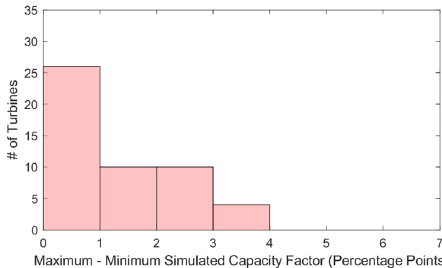
Figure 9. Maximum minus minimum SAM simulated capacity fac- tor based on wind resource data adjusted via four vertical interpo- lation techniques across 50 small wind turbines. Five small wind turbines are redacted from the analysis since their hub heights di- rectly align with a WIND Toolkit output height, thus eliminating the need for vertical